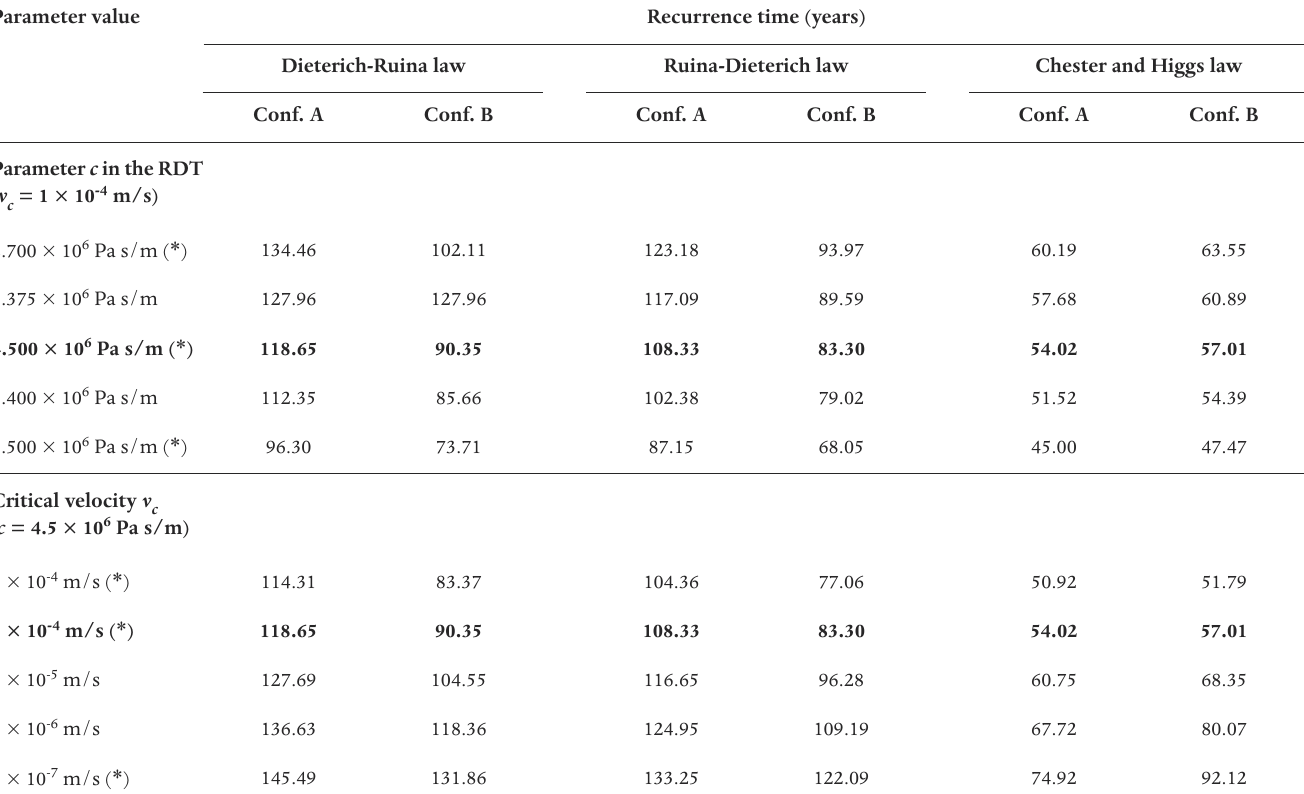
Table 3. Recurrence times for the different governing laws and the two configurations listed in Table 1 resulting from the sensitivity study (see Section 3.2). Values reported in bold represent the reference configurations. Asterisks denote the simulations reported in Figures 4 and 5. Conf., configuration.